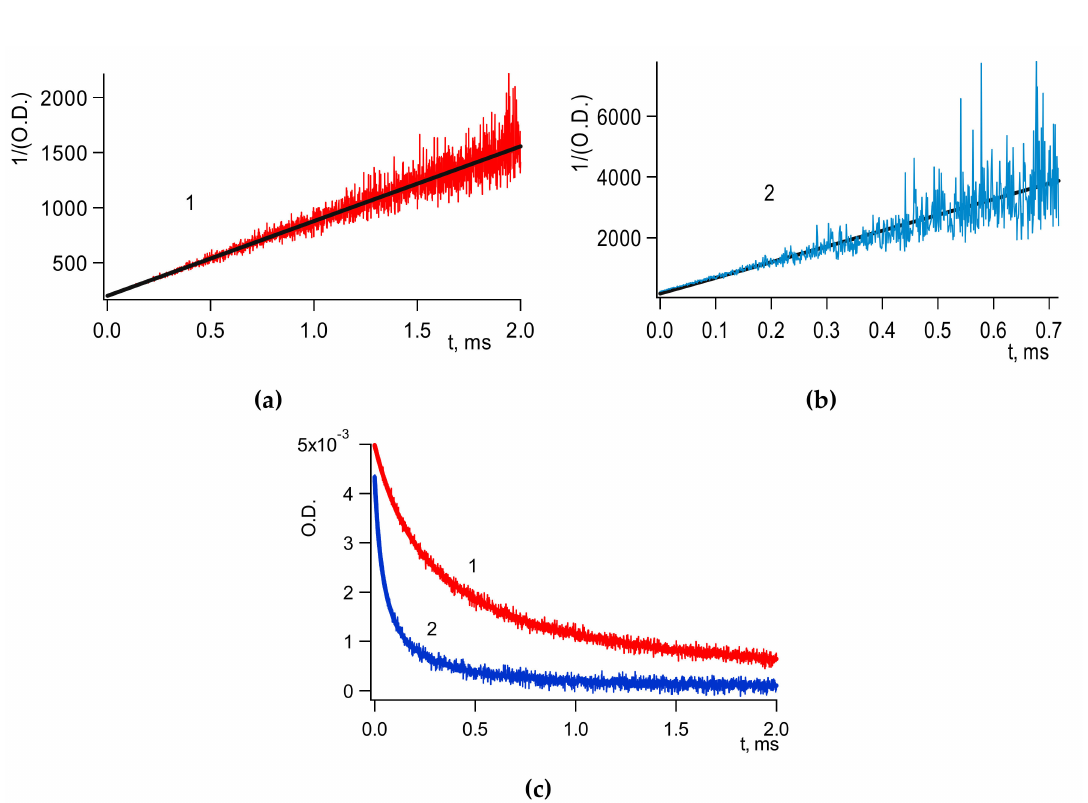
Figure 2. Decay kinetics of BH • measured at λ 545 nm at times ≥ 10 µ s obtained under laser flash photolysis of B in E films at 263 (1) and at 313 K (2). The top of the figure: A fit of curves into the second-order kinetic law. Adapted from Ref. [23]. ( a ) A fit of curve 1 of the figure c; ( b ) A fit curve of curve 2 of the figure c; ( c ) Experimental kinetic